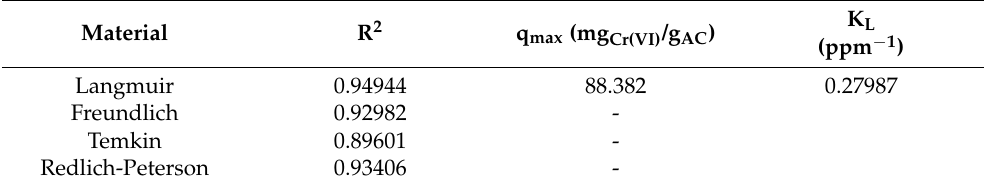
Figure 8. Test for the appropriate adsorption model ( a ) as well as for the appropriate kinetic model (i.e., PFO or PSO) to predict the Cr(VI) removal mechanism from aqueous solutions for different initial Cr(VI) concentrations i.e., 2.41 ppm ( b ), 5.24 ppm ( c ), 10,87 ppm ( d ), 19.83 ppm ( e ), and 39.64 ppm ( f ). Table 4. Correlation coefficient values resulted from the comparison of four adsorption models assuming maximum uptake capacity q max . Predicted Langmuir adsorption constant K L .